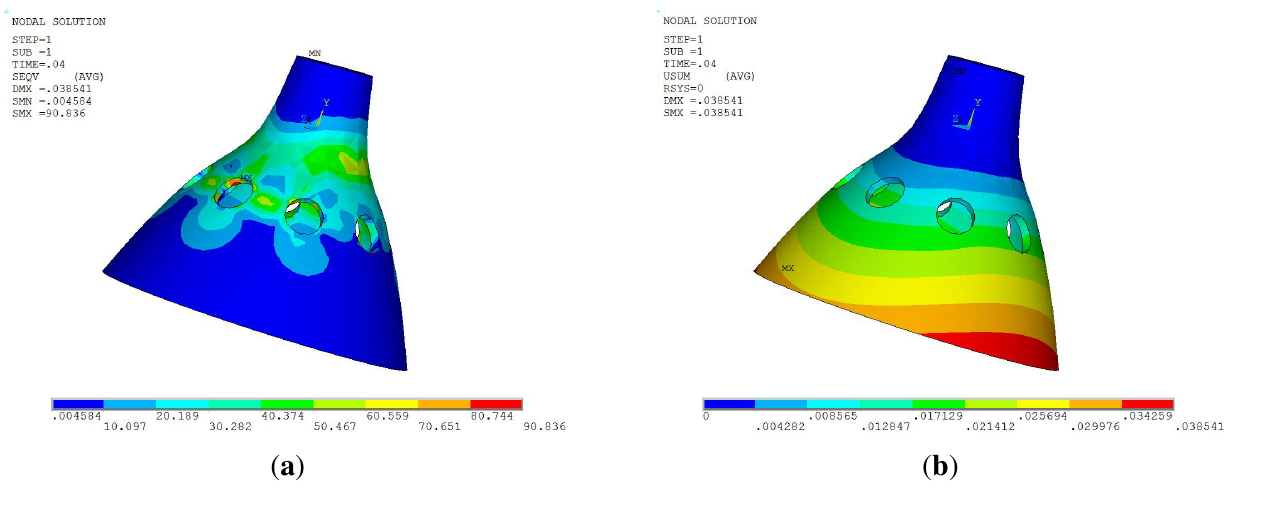
Figure 8. Schematic of the working principle.